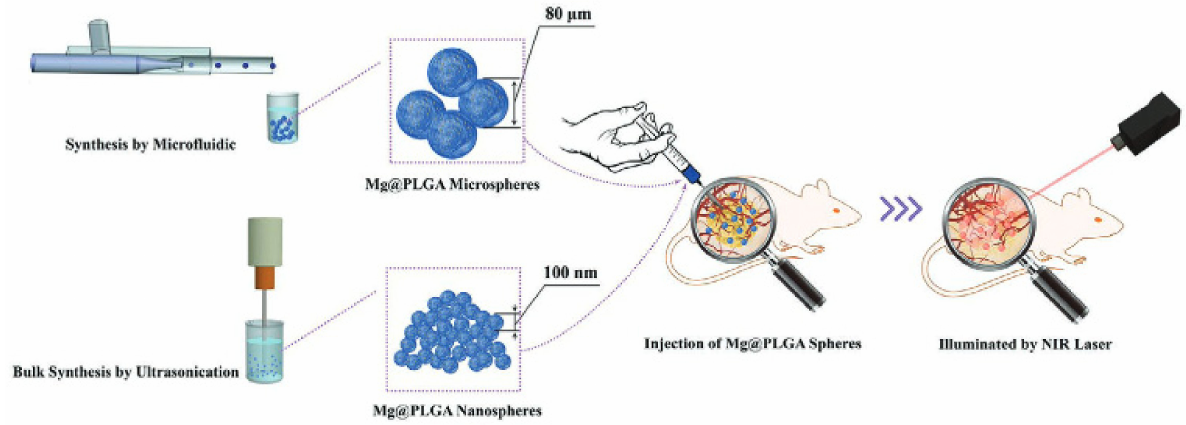
Figure 12. Schematic illustration of microfluidic and bulk methods for fabrication Mg@PLGA mi- crospheres and nanospheres for photothermal tumor treatments in vitro and in vivo. Adapted with permission from ref. [90]. 2021, John Wiley and